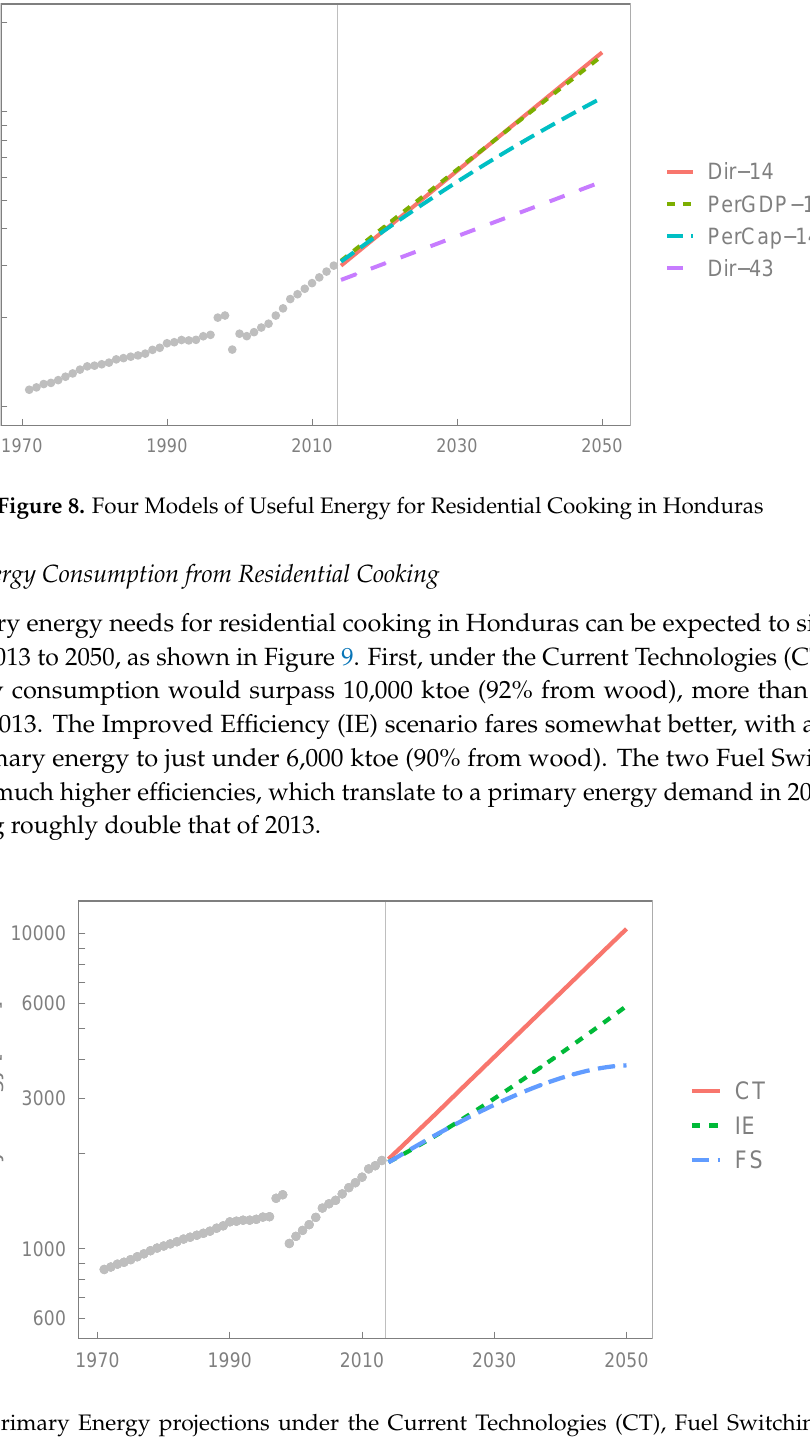
Figure 9. Primary Energy projections under the Current Technologies (CT), Fuel Switching (FS), and Improved Efficiency (IE) Scenarios. Vertical axis shown as logarithmic. Straight lines indicate exponential